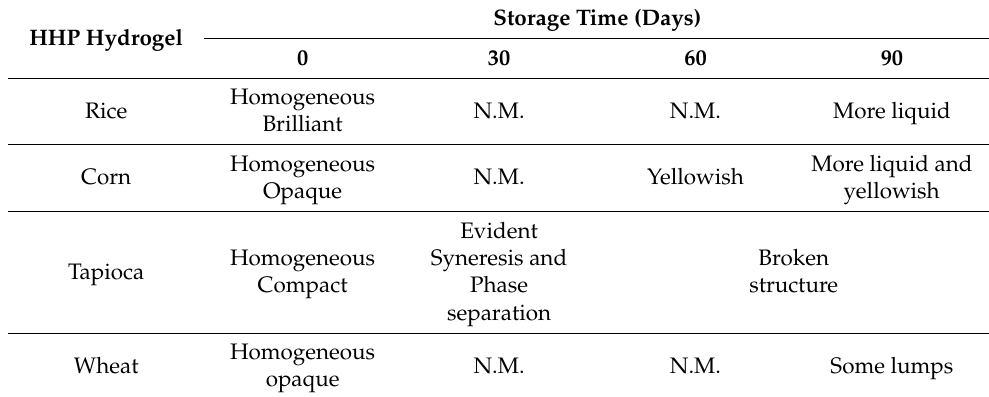
More liquid and yellowish Broken structure